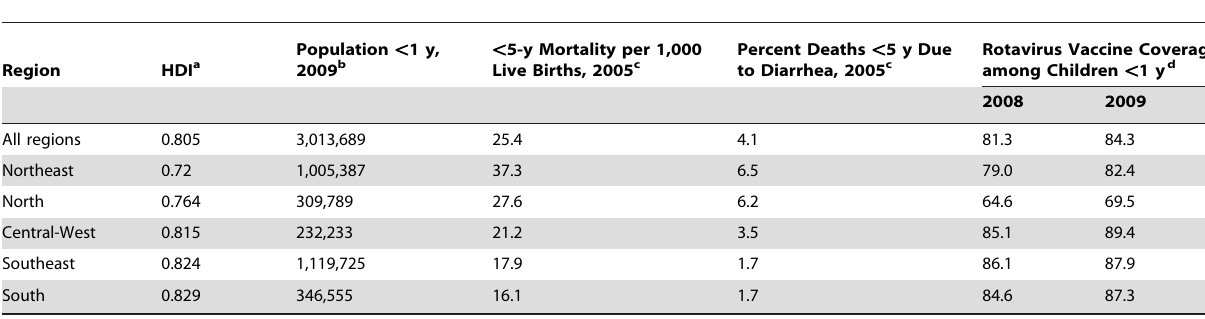
Table 1. Basic demographic, socioeconomic, and health indicators in Brazil, by region.